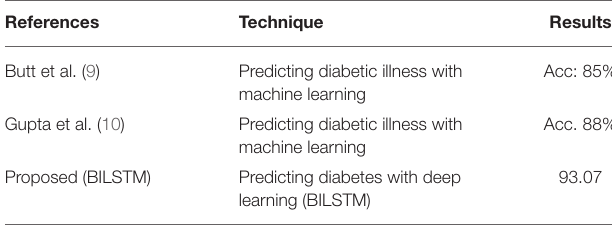
TABLE 4 | The BILSTM models’ accuracy, test loss, and training time.